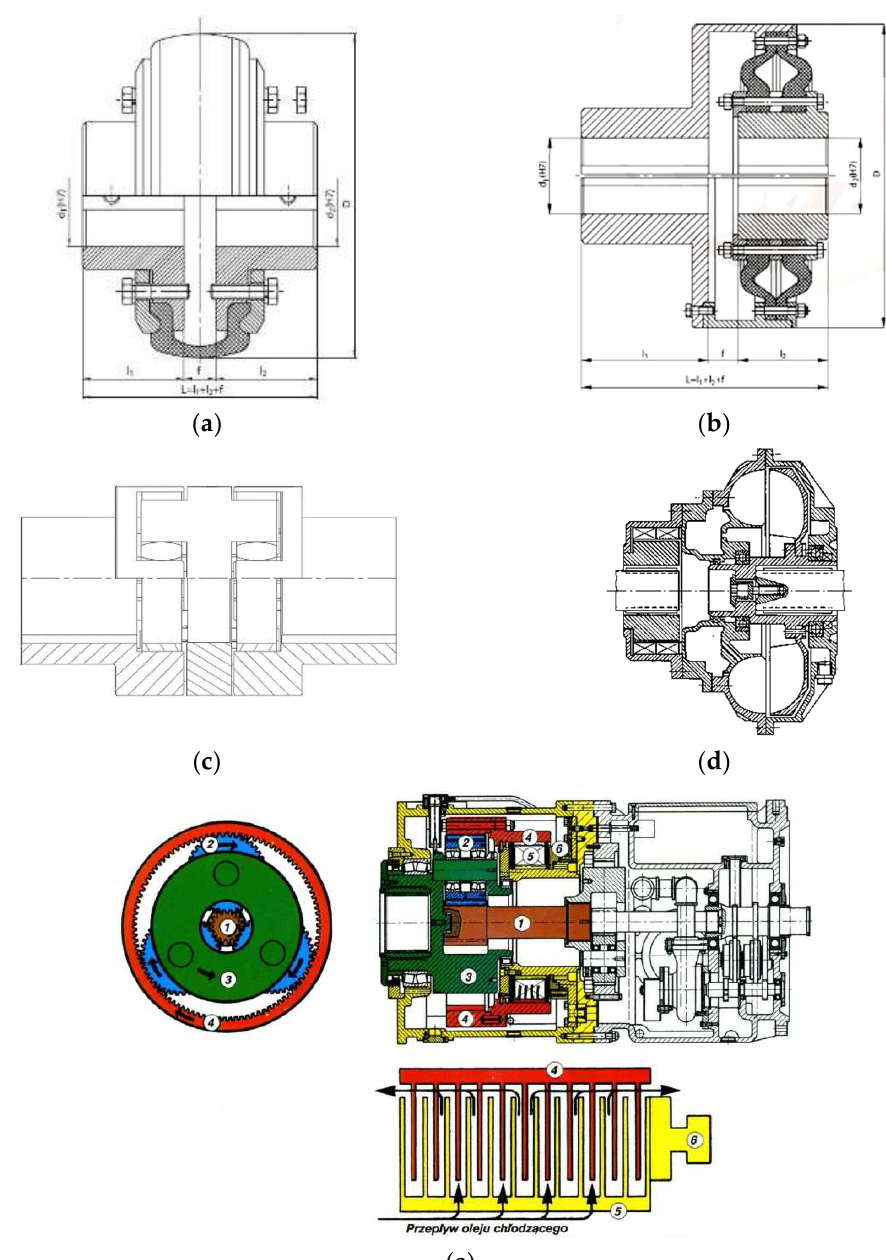
Figure 1. Schematic diagrams of different clutch types: ( a )—tyre clutch, ( b )—diaphragm clutch, ( c )—double-insert clutch, ( d )—hydrokinetic clutch, ( e )—CST multi-disc clutch integrated with a planetary gear; designations: 1—central gear wheel, 2—planet wheels, 3—cage with output shaft, 4—internal gear wheel with moving coupling disks, 5—stationary coupling discs, 6—actuator [50].